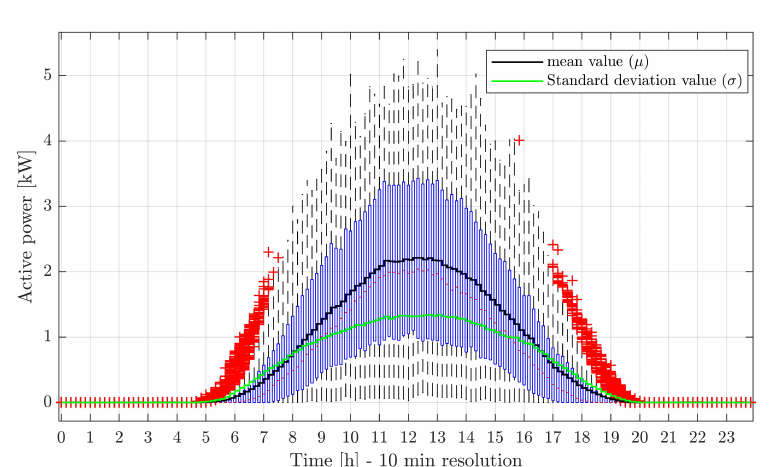
Figure 1. Box plot of a 5 kW PV inverter: output power derived from yearly meteorological data using the model in Section 2.1.